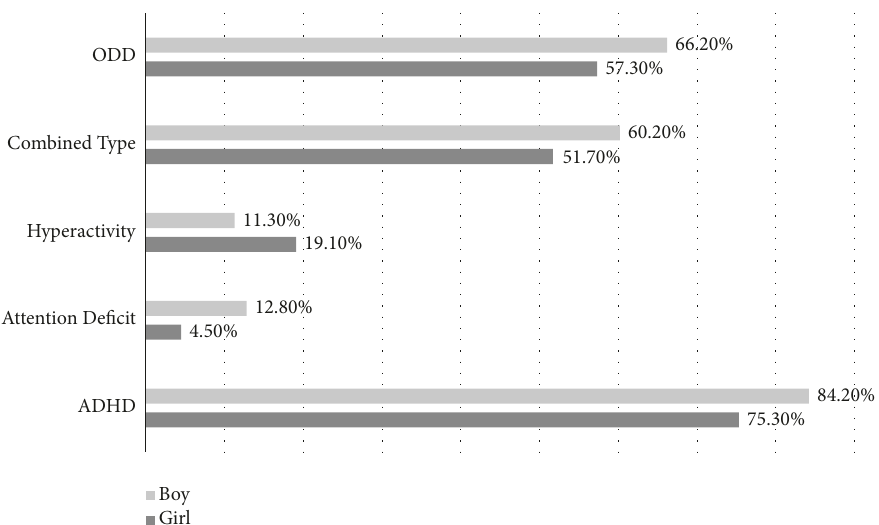
Figure 1: Prevalence of ODD diagnosis and ADHD subtypes according to scale cut-off scores (%). ODD: Oppositional Defiant Disorder and ADHD: Attention Deficit/Hyperactivity